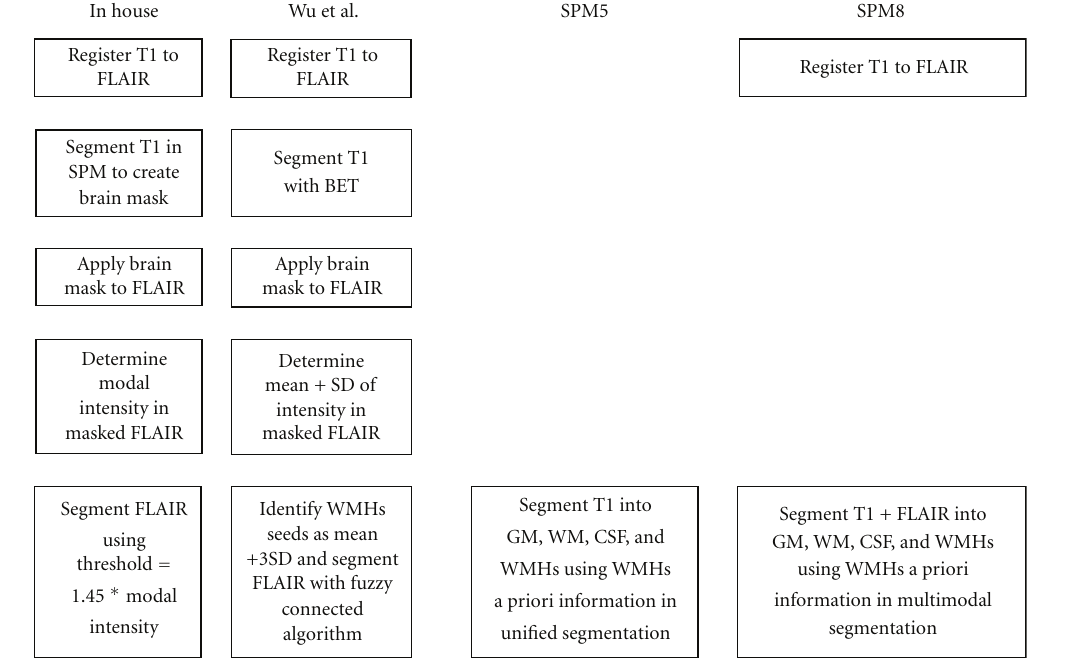
Figure 1: Overview of segmentation procedures.